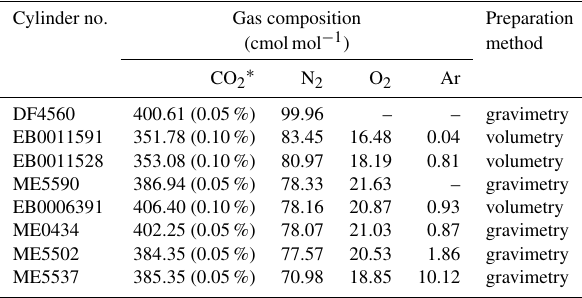
Table 2. Mole fractions of gas mixtures. Cylinder no. Gas